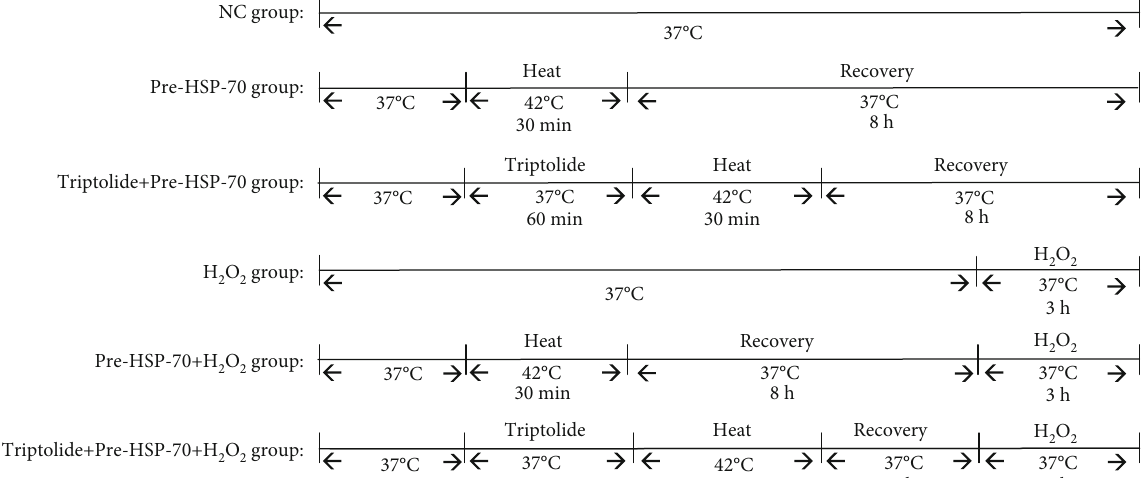
incubator for the entire experiment. 2 O for 3 h. Tripolide+H O 2 2 2 2